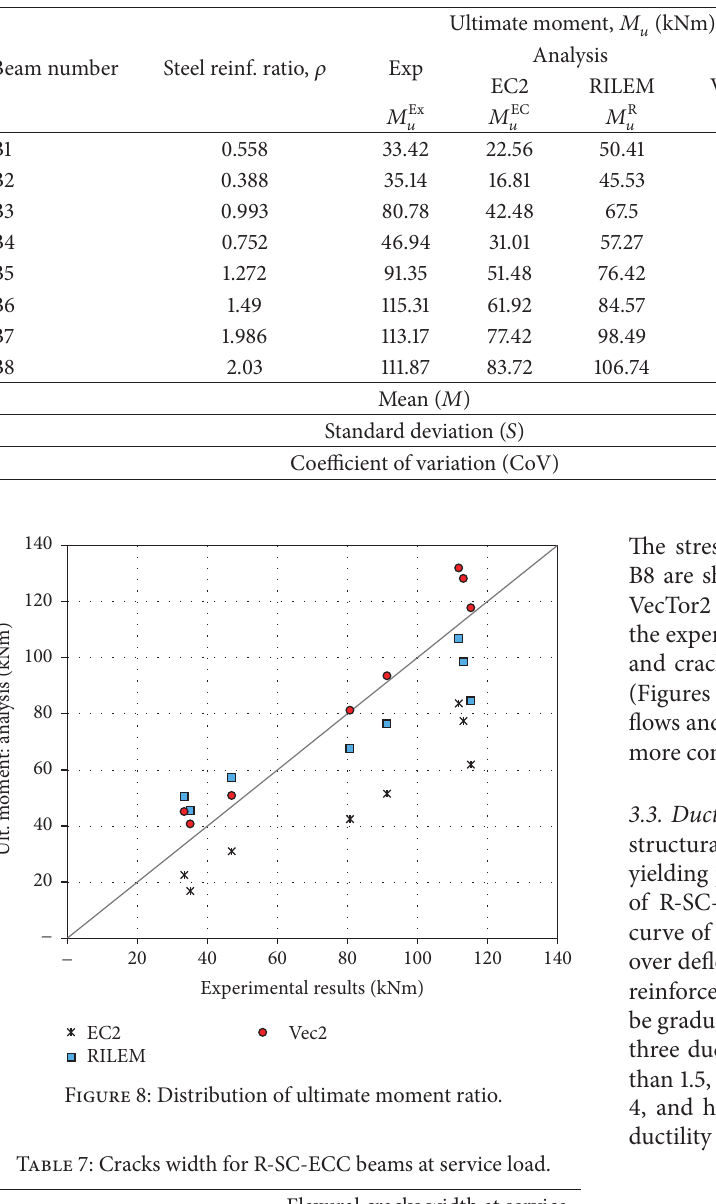
Table 6: Ultimate moment ratio for R-SC-ECC.